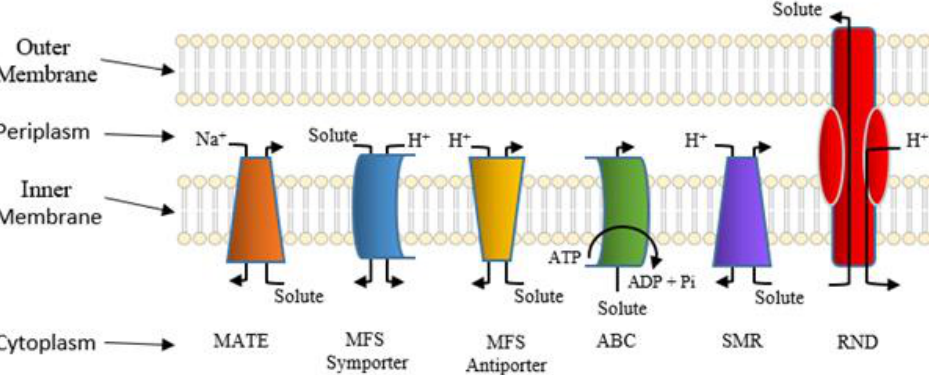
Figure 6. Classes of well-studied bacterial solute transporters. The bacterial outer and inner (cytoplasmic) membranes are shown. Also depicted are the cytoplasmic and periplasmic spaces. P i denotes phosphate, and Na + and H + denote sodium and proton, respectively. This figure kindly provided courtesy of Ann F. Varela.